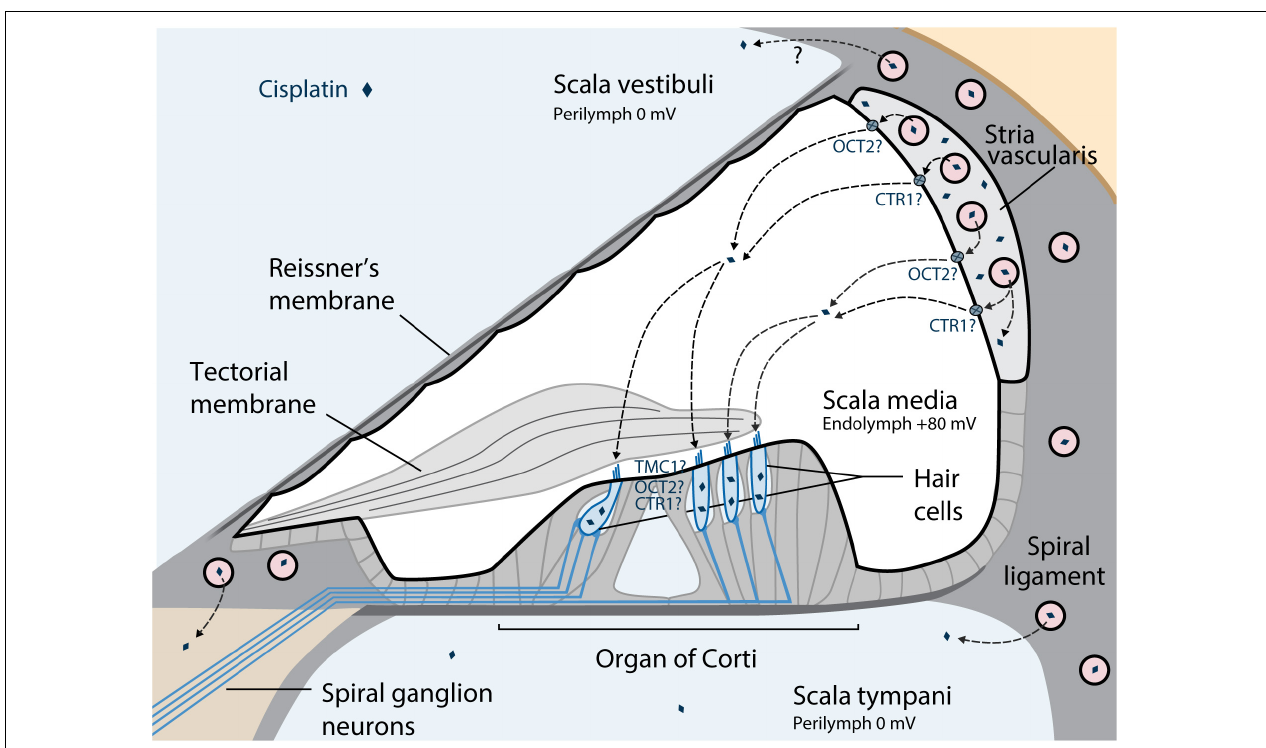
FIGURE 2 | Suggested pathways of cisplatin trafficking in the cochlea. The major entry route for cisplatin entry into the cochlea is via the blood-strial barrier into the stria vascularis, and clearance into the endolymph from the stria vascularis prior to entry into hair cells across their apical membrane. Reproduced with modifications from Kros and Steyger (2018) with permission of Cold Spring Harbor Laboratory Press. OCT2, Organic cation transporter; CTR1, Copper transporter 1; TMC1, Transmembrane channel-like protein